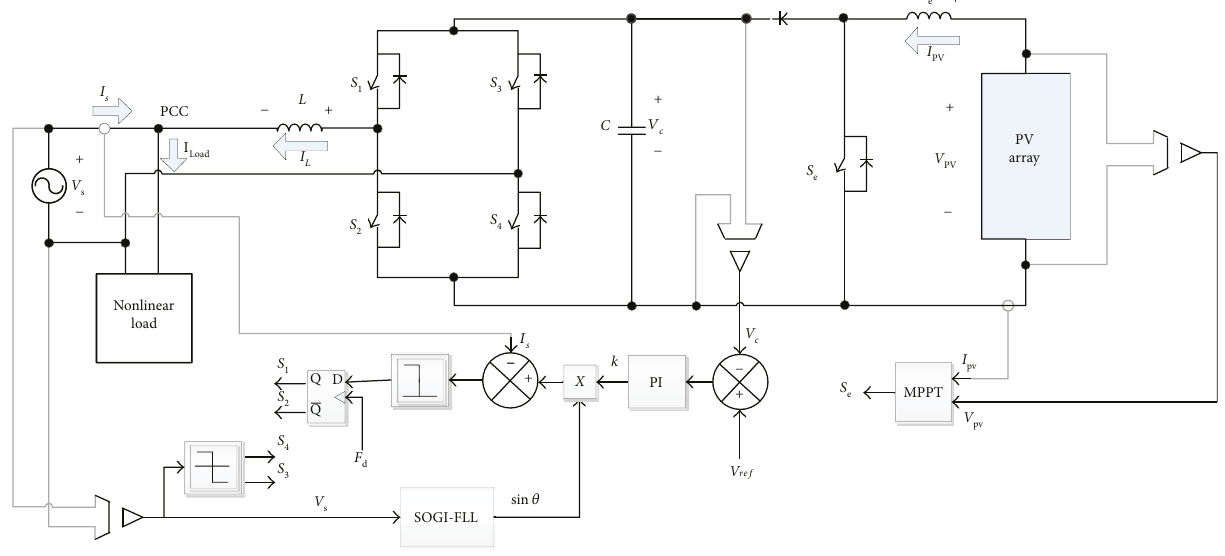
Figure 1: Block diagram of the power stage with a sliding mode controller.